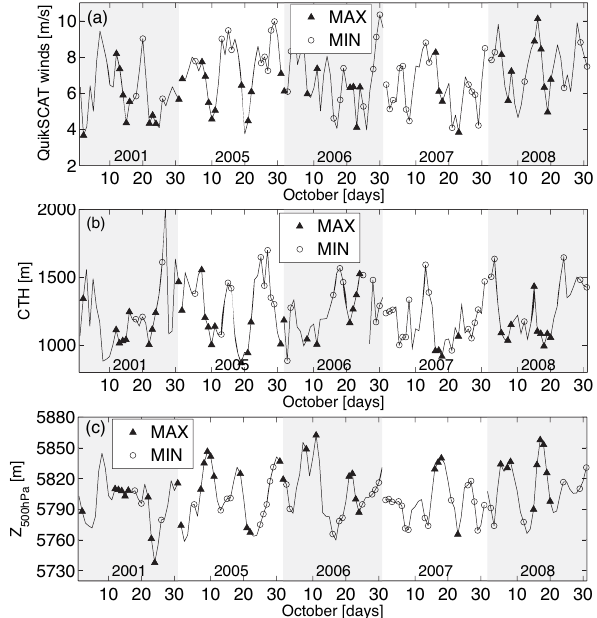
Fig. 3. Time series of: (a) mean surface winds (QuikSCAT) at 20 ◦ S–30 ◦ S, 70 ◦ W–90 ◦ W, (b) mean Terra-daytime MODIS- derived cloud top heights at 20 ◦ S–30 ◦ S, 70 ◦ W–80 ◦ W and (c) mean 500hPa geopotential height at 15 ◦ S–35 ◦ S, 70 ◦ W–100 ◦ W. Black triangles and open circles correspond to MAX and MIN N d days.